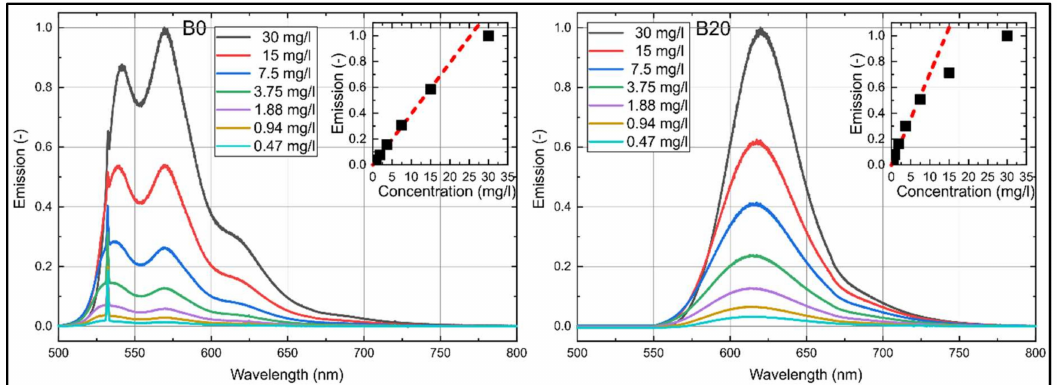
Figure 3. LIF emission spectra of nile red ( left : in n-decane (B0), right : in B20) normalized to the respective maximum intensity at 30 mg / L, inserted diagrams show linearity (B0: R 2 = 0.999, B20: R 2 = 0.993) of the integral LIF signal for various dye concentrations; 293